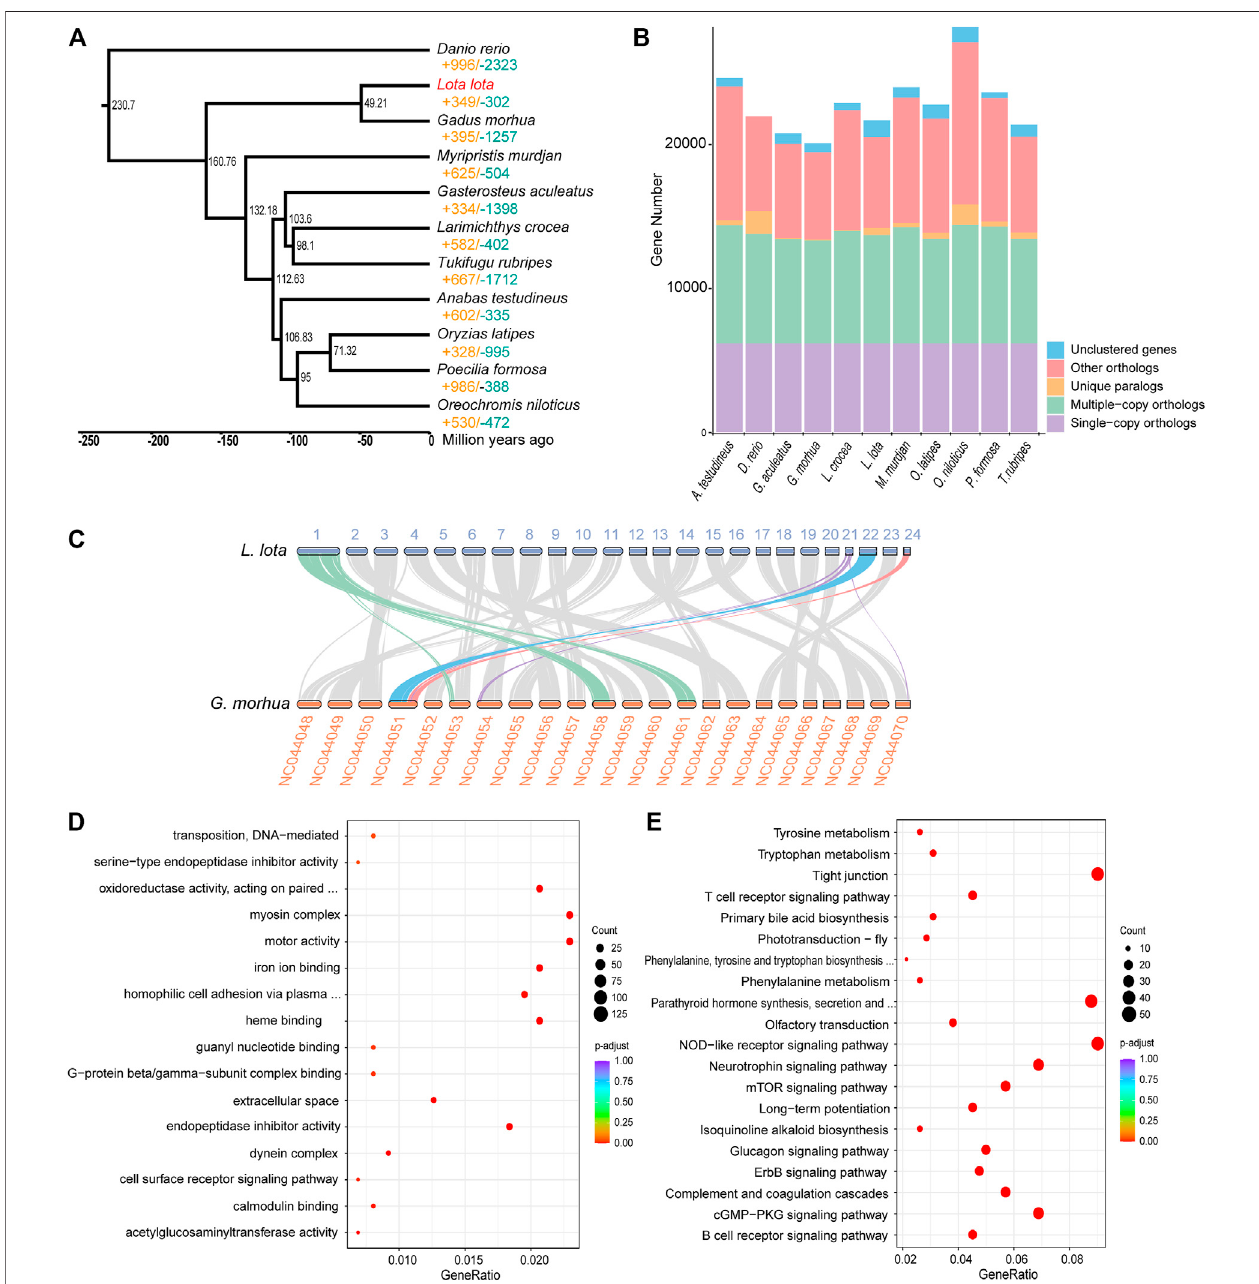
FIGURE 1 | Phylogeny, orthologs, collinearity, and gene family evolution. (A) Phylogeny, dating, and gene family evolution. The value of signi fi cantly expanded (orange) and contracted (blue) gene families is designated on each branch. The estimated species divergence time (million years ago) is labelled at each branch site. (B) Statistics of orthologs and paralogs. “ Others orthologs ” indicates unclassi fi ed orthologs; “ Unclustered genes, ” orthologs that cannot be assigned into any orthogroups. (C) Collinearity analysis of Lota lota and Gadus morhua genomes. (D) Function enrichment of Gene Ontology (GO) for signi fi cantly expanded gene families. (E) Kyoto Encyclopedia of Genes and Genomes (KEGG) enrichment analysis for signi fi cantly expanded gene families. Only the top 20 categories are shown.